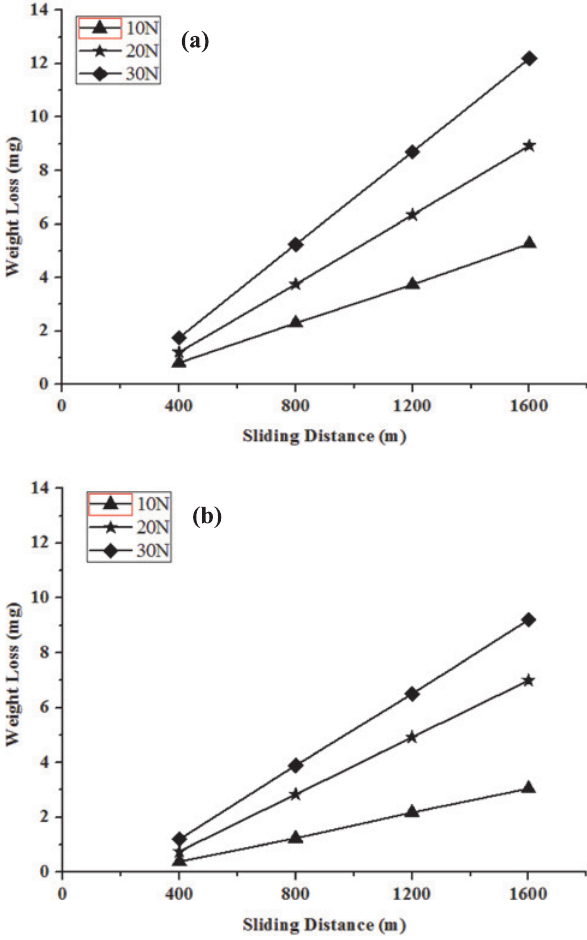
Fig. 3: Weight losses of the alloy T5 (a) and T6 (b) heat treatments according as the load and wear distance.